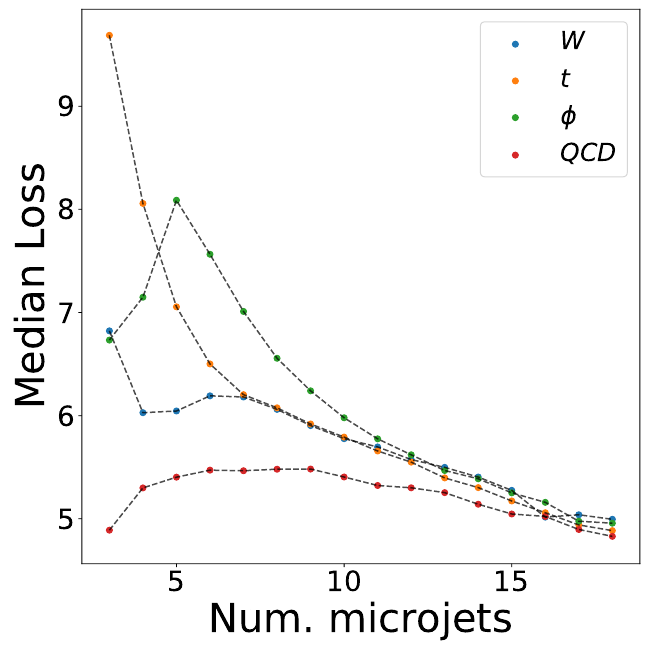
Figure 10 . The median loss of events (from the test dataset) with fixed number of microjets for the various types of